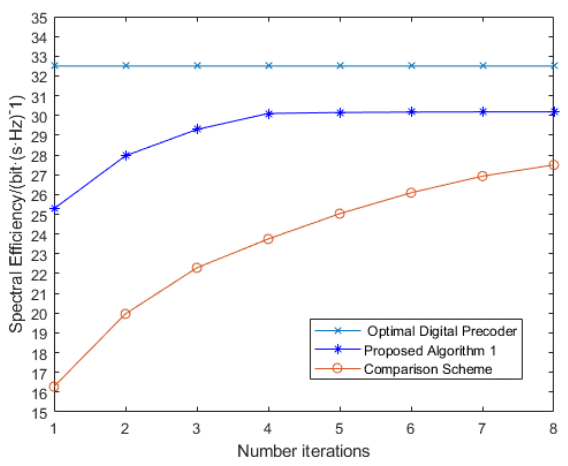
Figure 6. Spectral efficiency of the proposed algorithm with increasing iterations ( 𝑆𝑁𝑅 = 5𝑑𝐵 , N RF = 8, N s = 8).